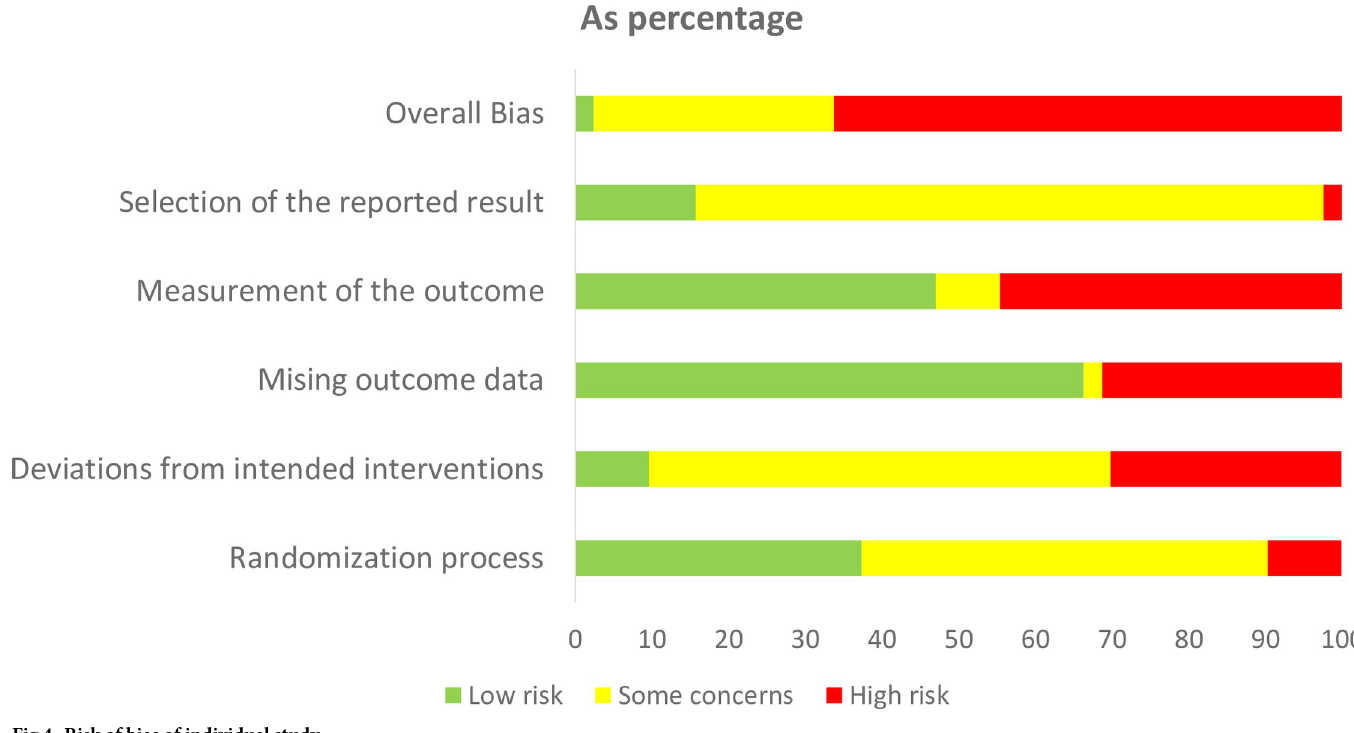
Fig 4. Risk of bias of individual